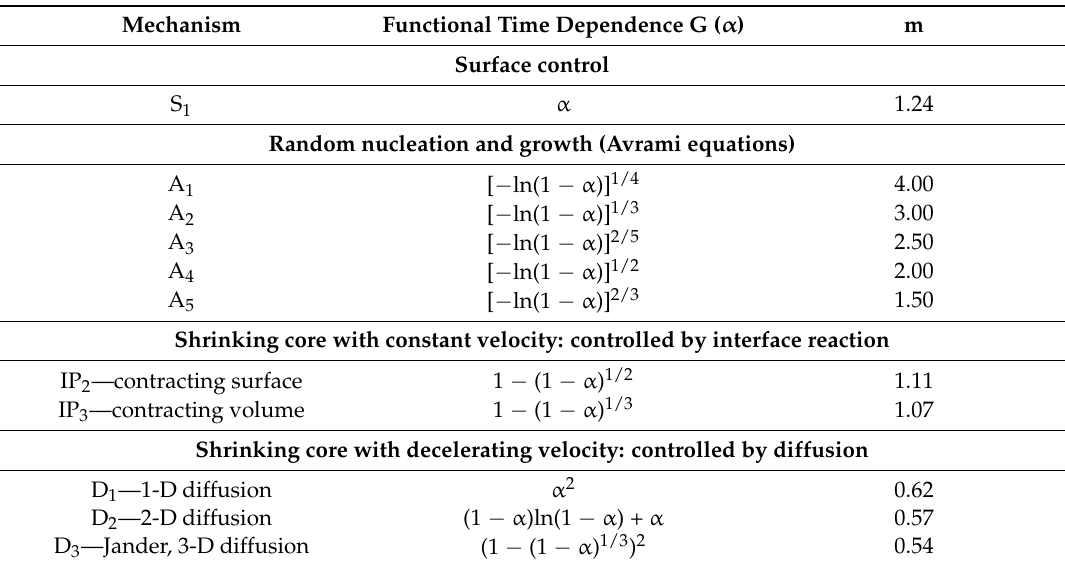
Table 2. Summary of main model functions describing solid–gas